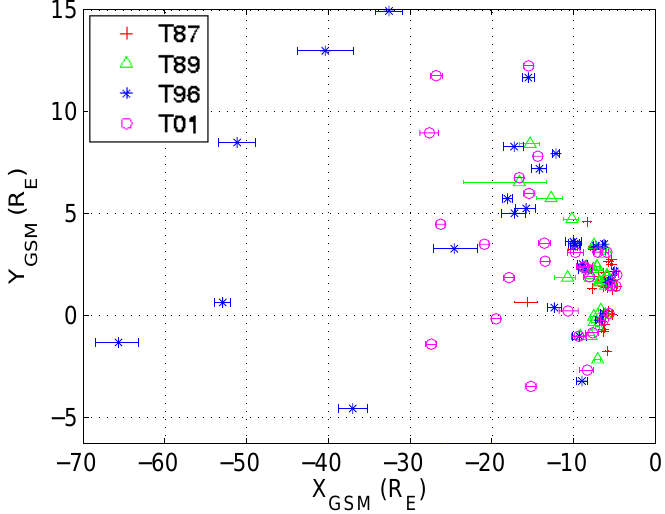
Fig. 5. Location of the model onsets in X-Y